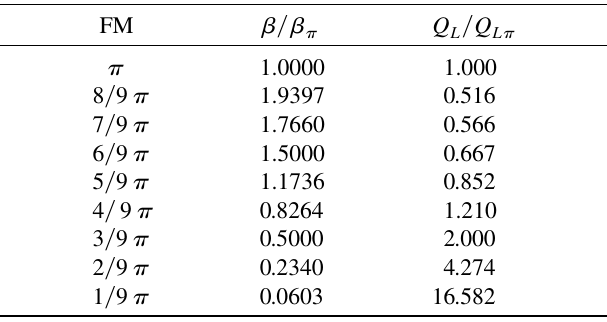
TABLE II. List of coupling factors and loaded quality factors of the FMs.